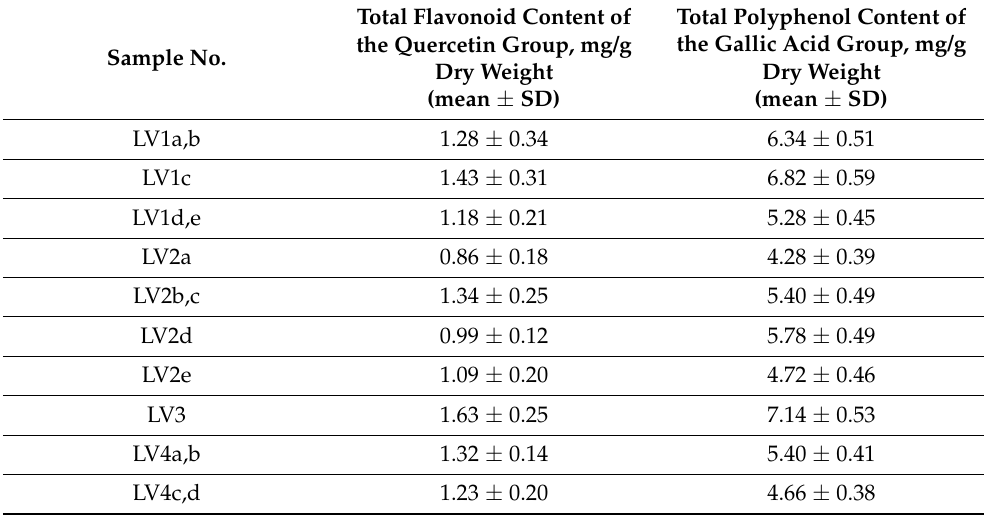
Table 4. Total flavonoid and polyphenol content for different samples of Lupinus polyphyllus . Total Polyphenol Content of Total Flavonoid Content of the Gallic Acid Group, mg/g the Quercetin Group, mg/g Sample No. Dry Weight Dry Weight (mean ± SD) (mean ± SD) LV1a,b 1.28 ±